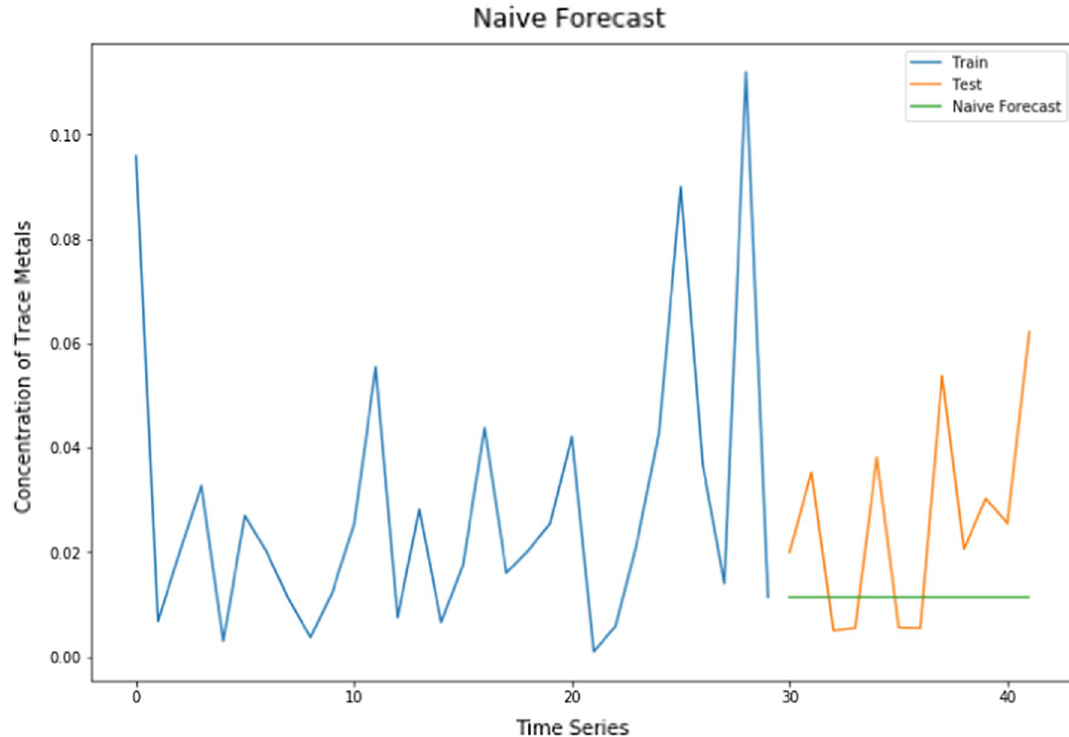
Fig. 6 Trace metals prediction using Naïve forecasting (machine learning with Python)